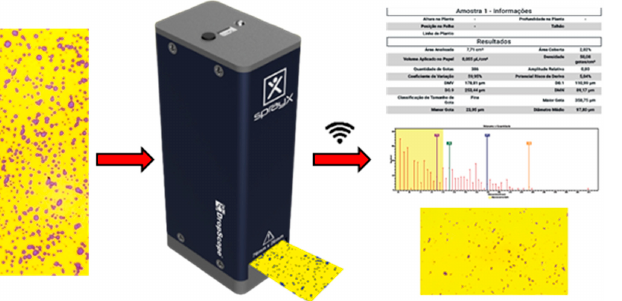
Figure 5. DropScope ® wireless system. The red arrow indicates the manner in which the samples were collected.